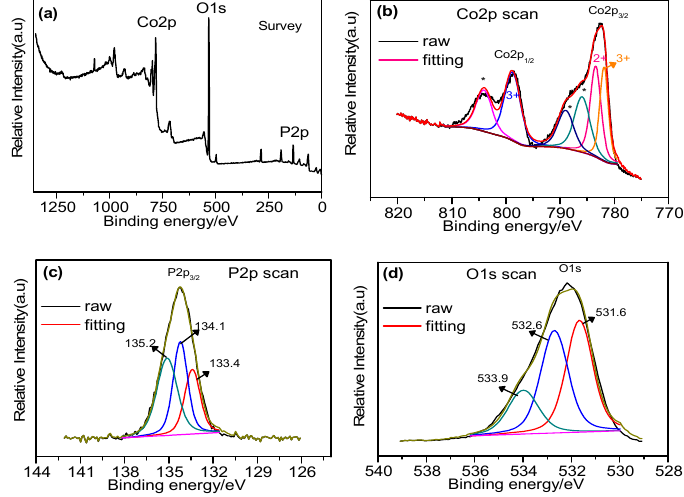
Figure 5. ( a ) X-ray photoelectron spectroscopy (XPS) survey spectrum of Co 3 (PO 4 ) 2 nanospheres, ( b ) Co 2p , ( c ) P 2p , and ( d ) O 1s spectra of Co 3 (PO 4 ) 2 nanospheres. (* indicates satellite